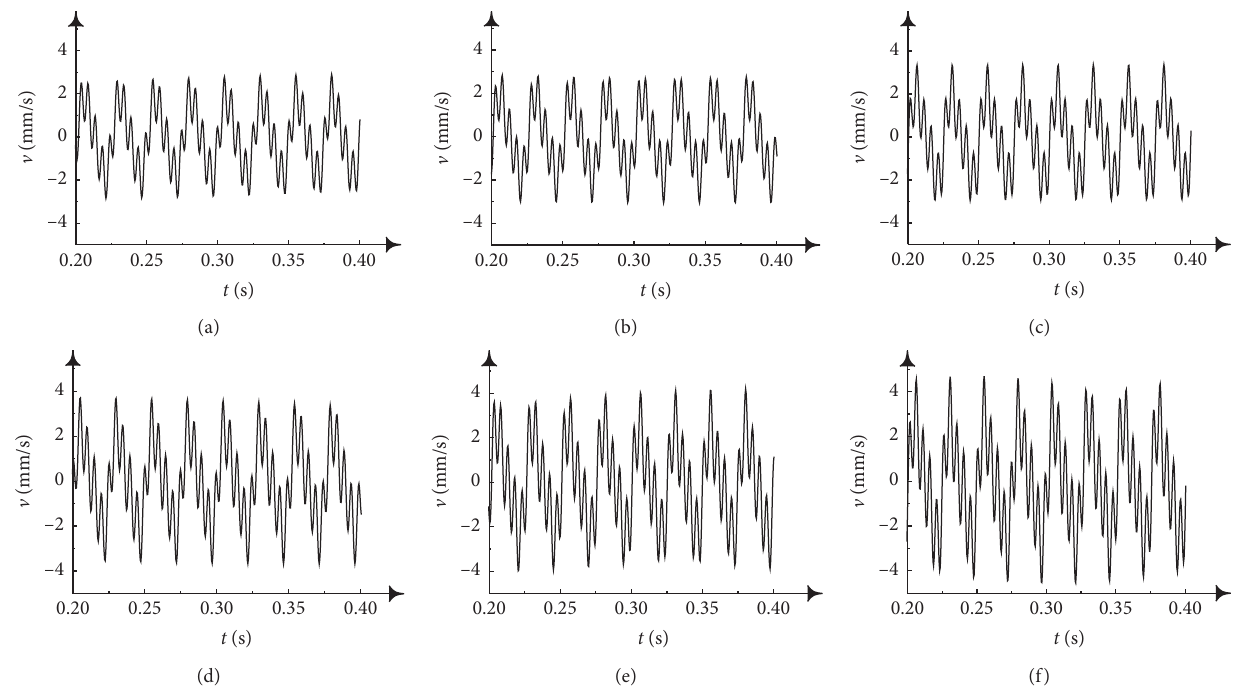
Figure 6: Vertical velocities of the inner ring in various temperatures. (a) T � 100K. (b) T � 200K. (c) T � 300K. (d) T � 400 K. (e) T � 500K. (f) T � 600K.